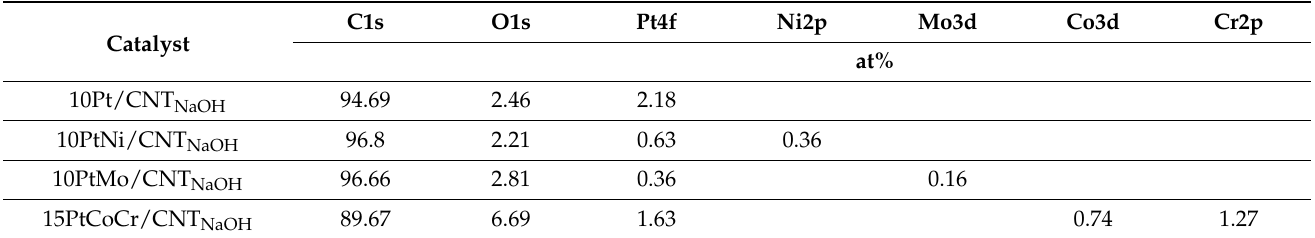
Table 1. Surface composition (XPS, at %) of studied catalysts.